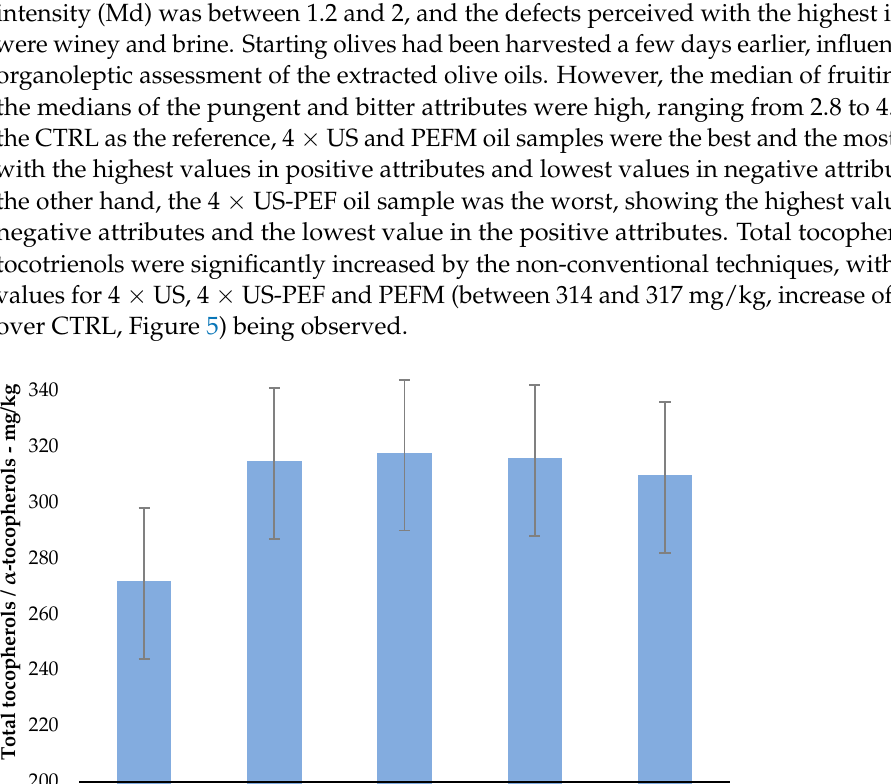
Figure 6. Tocopherol content in oil samples obtained from half-ripe Coratina olives according to processing technology (mg/kg). The amounts of β - and δ -tocotrienols (orange and yellow bars, Figure 7) were not influenced by the applied non-conventional techniques. On the other hand, the contents of γ - and α -tocotrienols (grey and blue bars, Figure 7) were strongly increased by 4 x US-